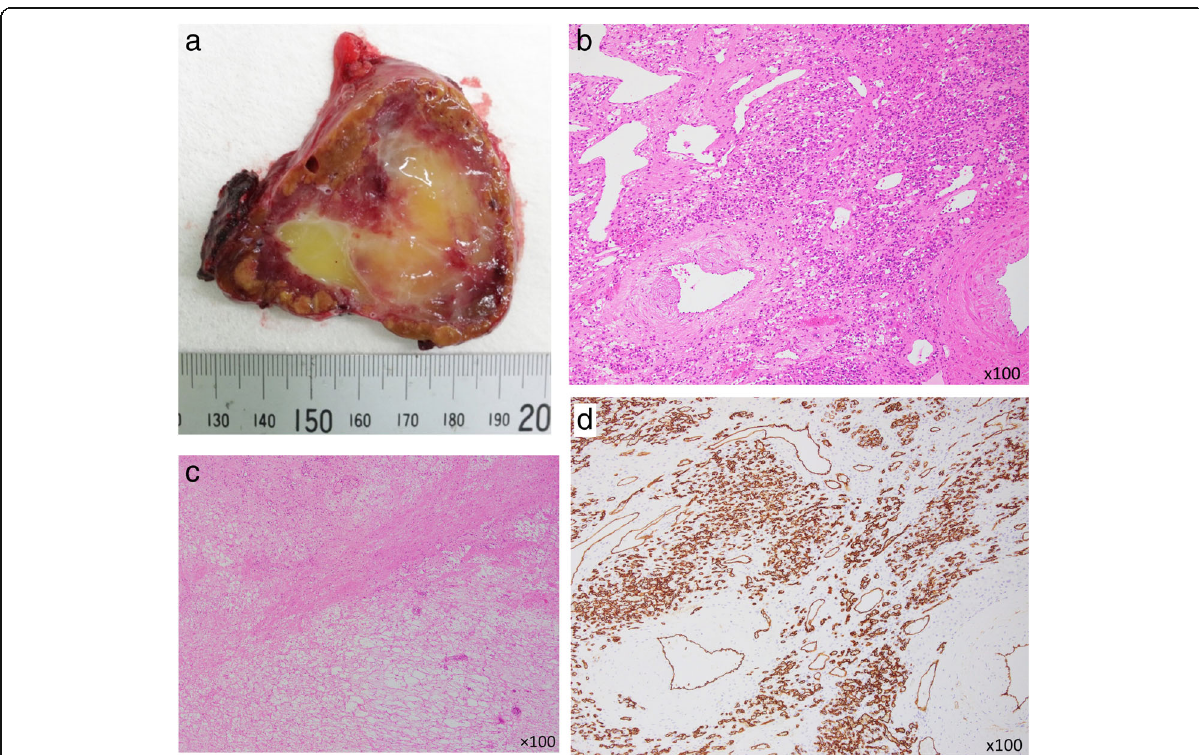
Fig. 3 Resected specimen. The cut surface of the tumor in S1 reveals a 55 × 56 mm, well-demarcated, homogeneous, yellowish-white solid mass ( a ). The tumors were composed of various sized irregularly dilated vessels with fibrous and hyalinized sclerotic stroma (hematoxylin and eosin staining, H&E; b , c ), CD34 positive vascular components ( d